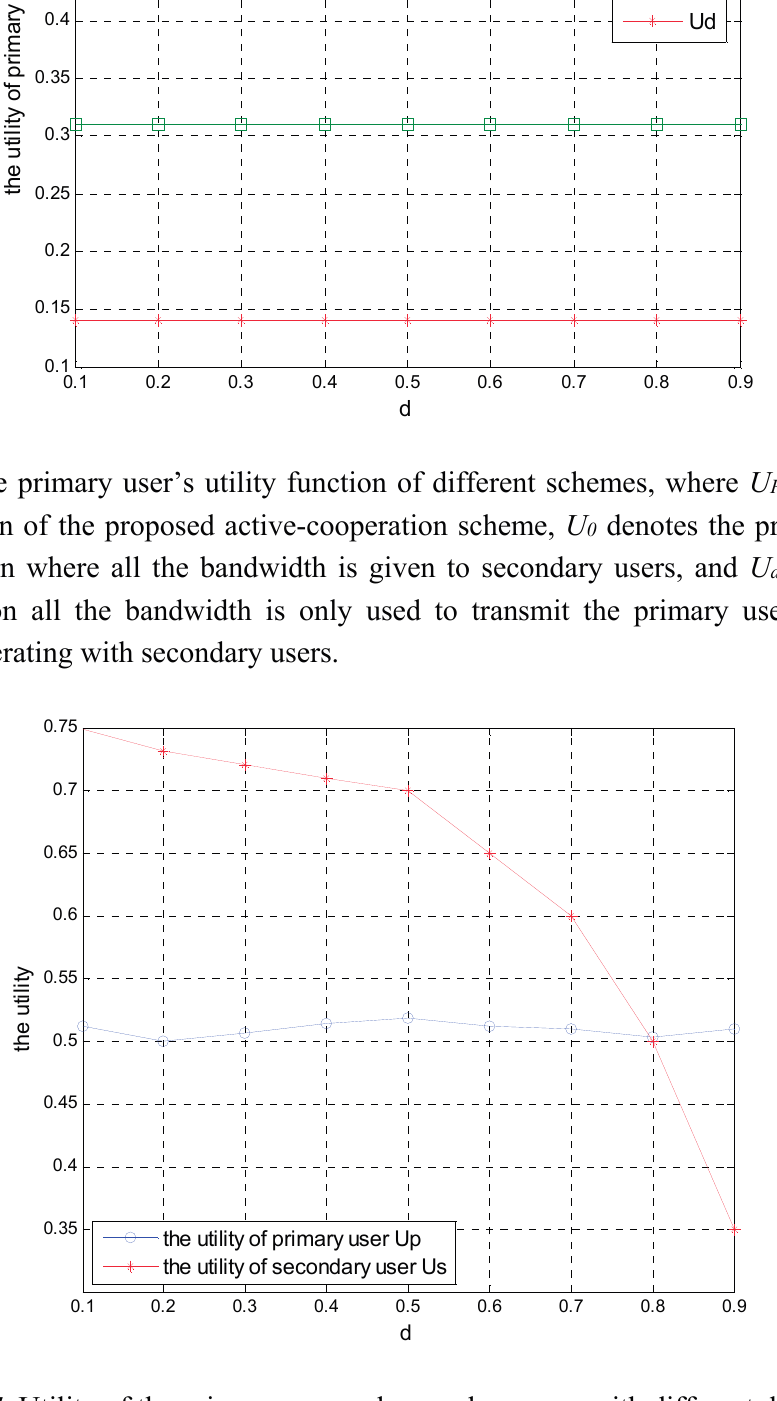
Figure 7. Utility of the primary user and secondary users with different distance. Figure 8 reflects the relationship between the utility function and the number of secondary relays under three different schemes as analyzed above. When the distance between the primary user